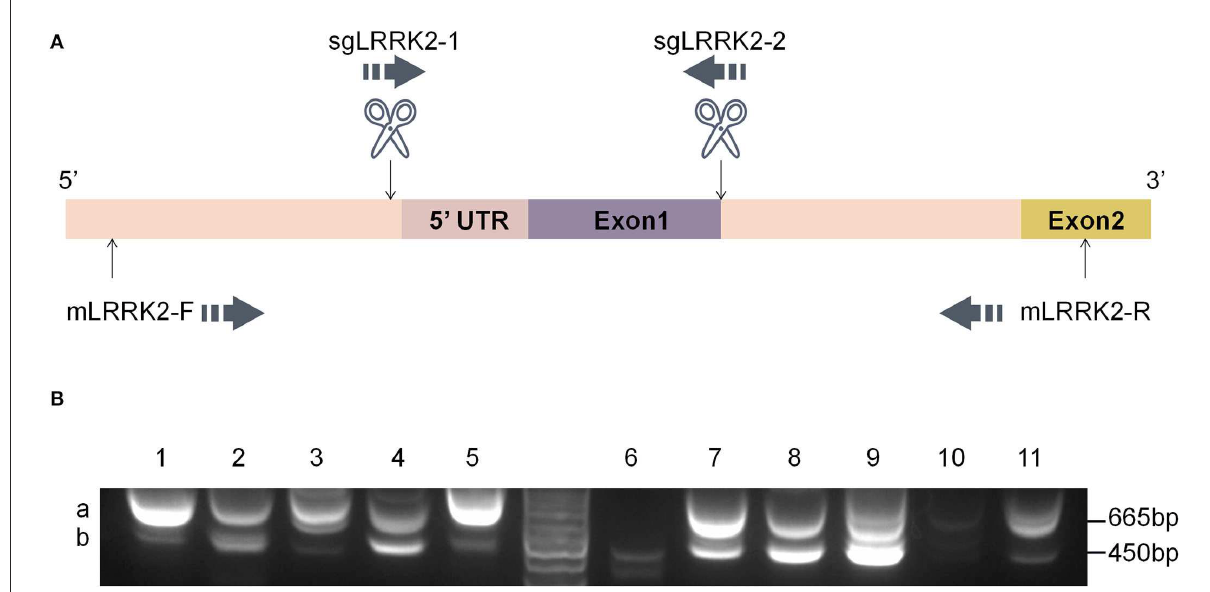
FIGURE2 Dual-sgRNA targeting strategy. (A) A pair of sgRNAs were designed to target the N terminus of LRRK2 ; sgLRRK2-1 is located upstream of the 5’UTR, and sgLRRK2-2 spans exon 1/intron 1. The primers for genomic PCR, mLRRK2-F and mLRRK2-R, were located upstream and